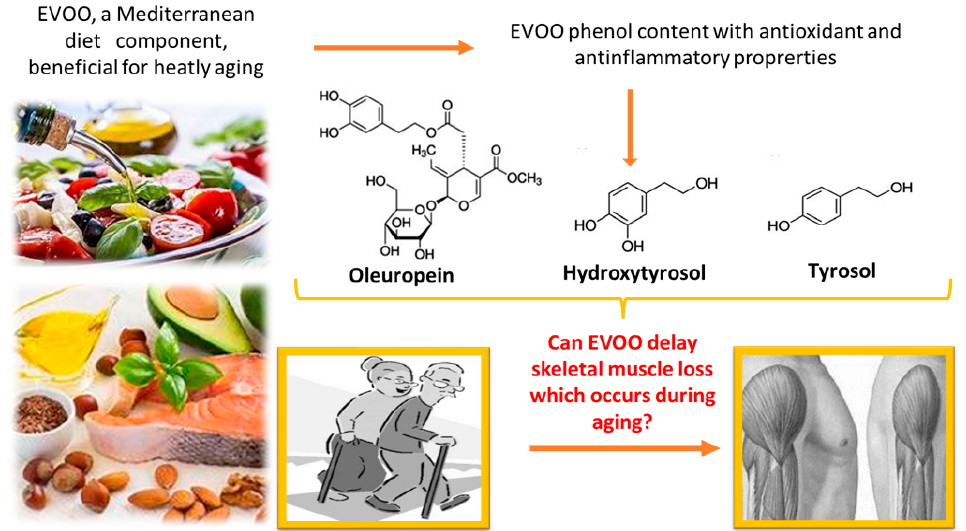
Figure 3. EVOO contains phenolic compounds such as Oleuropein, Hydroxytyrosol and Tyrosol with antioxidant and anti-inflammatory properties which could be useful for sarcopenia prevention.